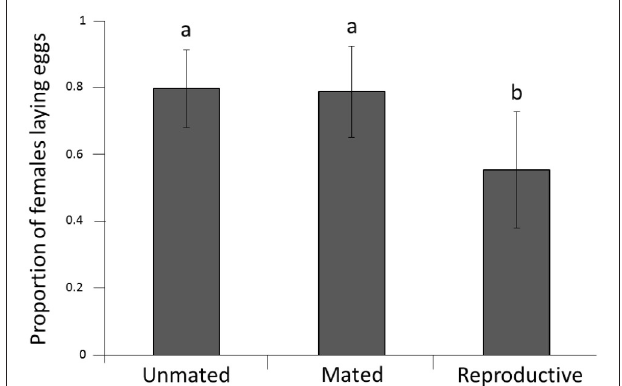
FIGURE 2 | Proportion of females ovipositing after cold stress at − 1.5 ◦ C. Error bars represent the 95% confidence interval around estimates of the mean. Lower case letters represent significant